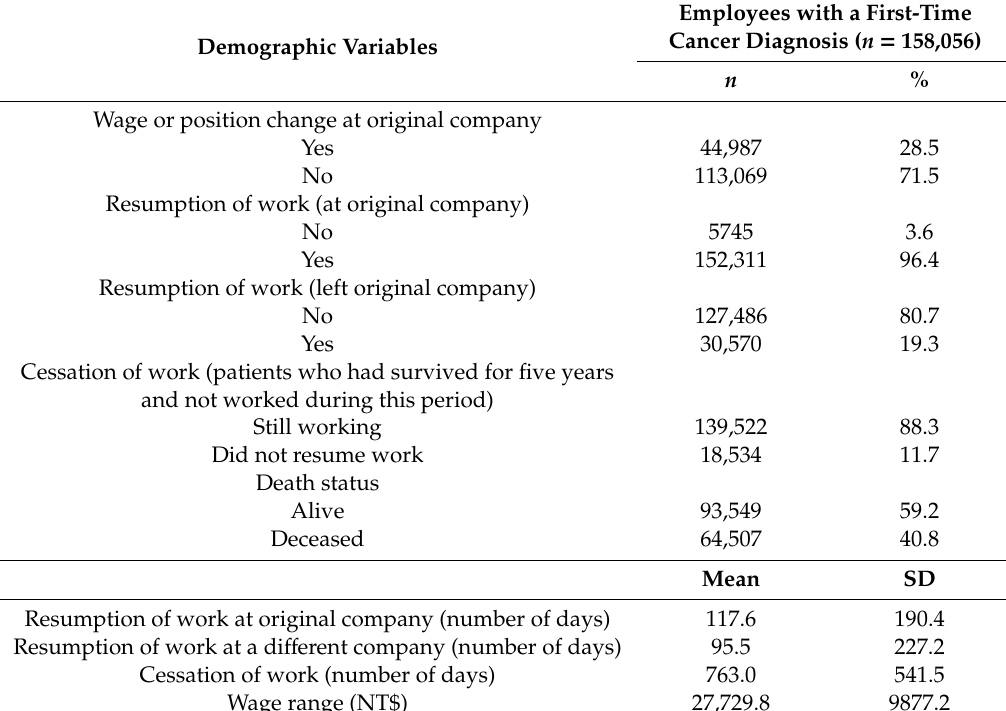
Table 5. Change of employment status within at least 5 years of diagnosis among insured workers with a first-ever cancer diagnosis in Taiwan a .